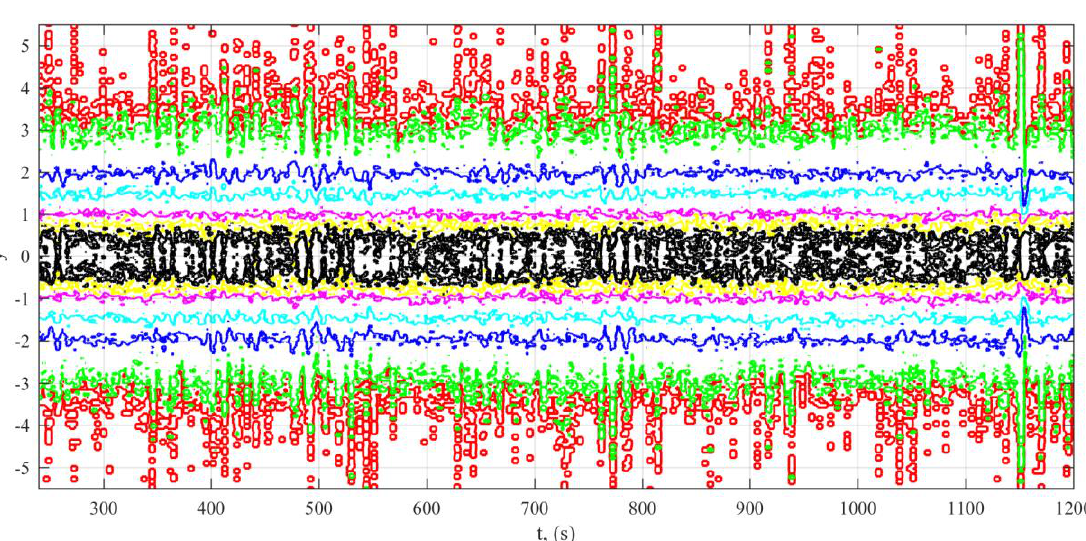
Figure 6. Underwater noise signal after AGC and normalization by the level. Lines of equal probability for consecutive PDF for T = 1 s. This is lines of equal probability of the values of w(y): 0.000134 (red), 0.004432 (green), 0.053991 (blue), 0.1295 (cyan), 0.241971 (magenta), 0.3521 (yellow), 0.3867 (black). For the Gaussian distribution with the mean equal to 0 and variance equal to 1, this would be corresponding to the straight lines—also in accordance with values of y: ±4, ±3, ±2, ±1.5, ±1, ±0.5, ±0.25. The proper T value in order to detect change in PDF is determined in accordance with the set